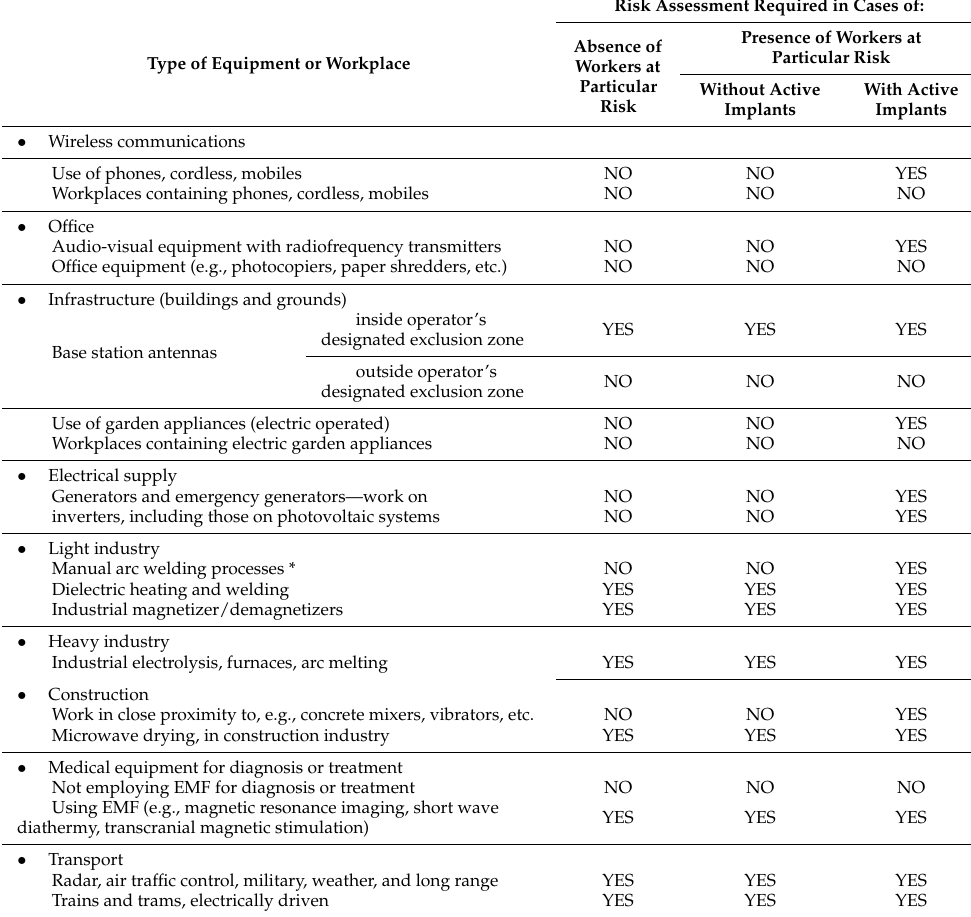
Table 2. Indications for electromagnetic fields (EMF) risk assessment in different occupational settings, summarized and adapted from the “non-binding guide” of the European Commission [2]: non-exhaustive